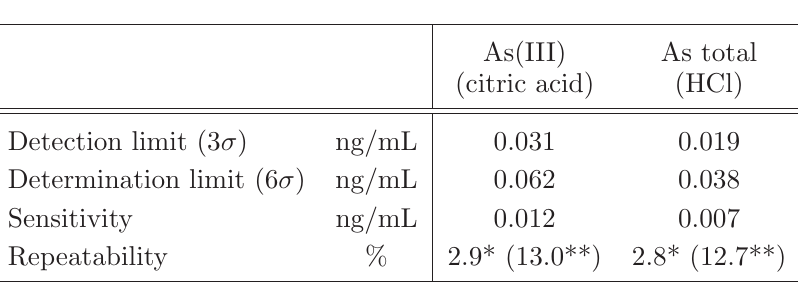
Table 3 Parameters of the analytical method combining the atomic absorption spectroscopy with hydride generation and in-situ analyte trapping in a graphite tube (HG-GFAAS), (n=6).